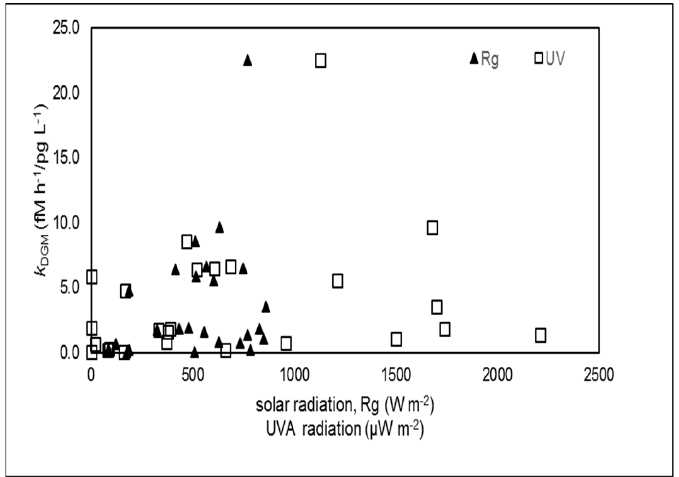
Figure 4. The relationship between the model-calculated rate constants of aquatic Hg photoreduction and solar radiation parameter (global radiation). The model-calculated rate constants plotted include the entire calculated rate constants covering both warm and cold seasons.